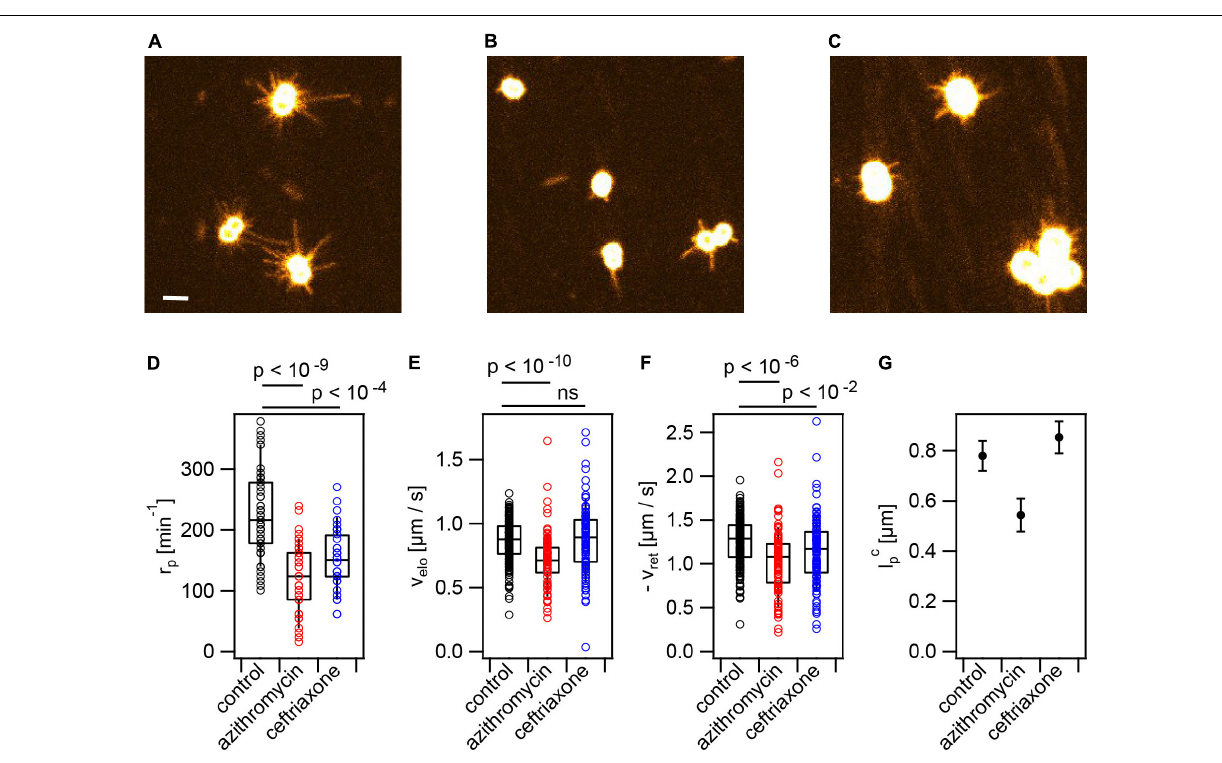
FIGURE 3 | Antibiotic treatment reduces T4P production rate. Cells (Ng226) were treated with azithromycin or ceftriaxone, respectively, at twofold MIC for 3 h. Typical images of fluorescent T4P (A) without treatment, (B) with azithromycin, (C) with ceftriaxone. Scale bar: 2 µ m. (D) Rate of T4P production, r p ( > 35 cells for each condition). (E) T4P elongation velocities, v elo ( > 85 T4P for each condition). (F) T4P retraction velocities, v ret ( > 96 T4P for each condition). Shown are circles: single T4P data, box: 25/75 percentiles, and median for 171 T4P. p -values obtained from KS test. (G) Characteristic maximum T4P lengths l c p and errors obtained from exponential fits to the length